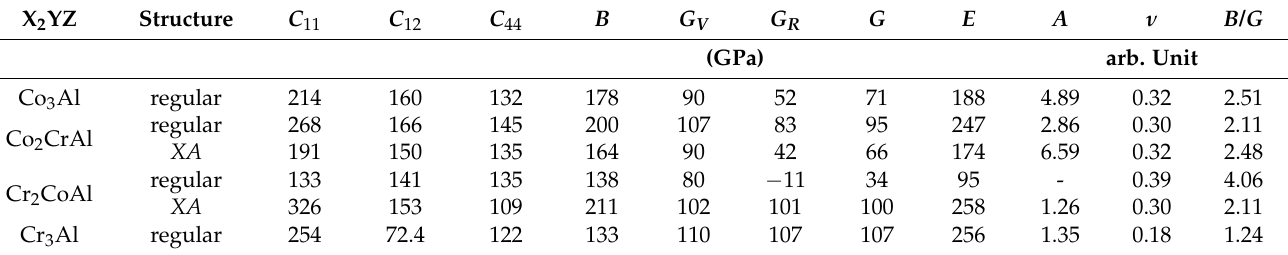
Table 2. Our calculated elastic constants C 11 (GPa), C 12 (GPa) and C 44 (GPa), bulk modulus β (GPa), shear modulus G (GPa), Young’s modulus E (GPa), anisotropy factor A (arb. unit) and Poisson’s ratio ν (arb. unit) of all considered Co 3 − x Cr x Al Heusler